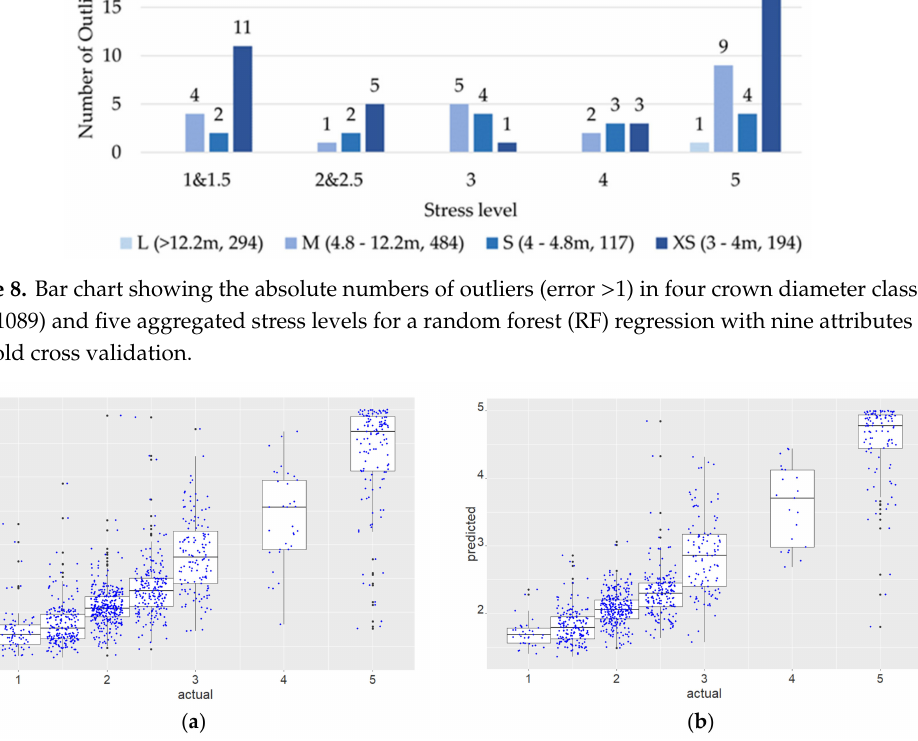
Figure 9. A combination of jitter and boxplot diagrams for an RF regression on WV2 attributes for the seven stress levels, based on ( a ) crowns with a diameter larger than 3 m (1089) and ( b ) crowns with a diameter larger than 4 m